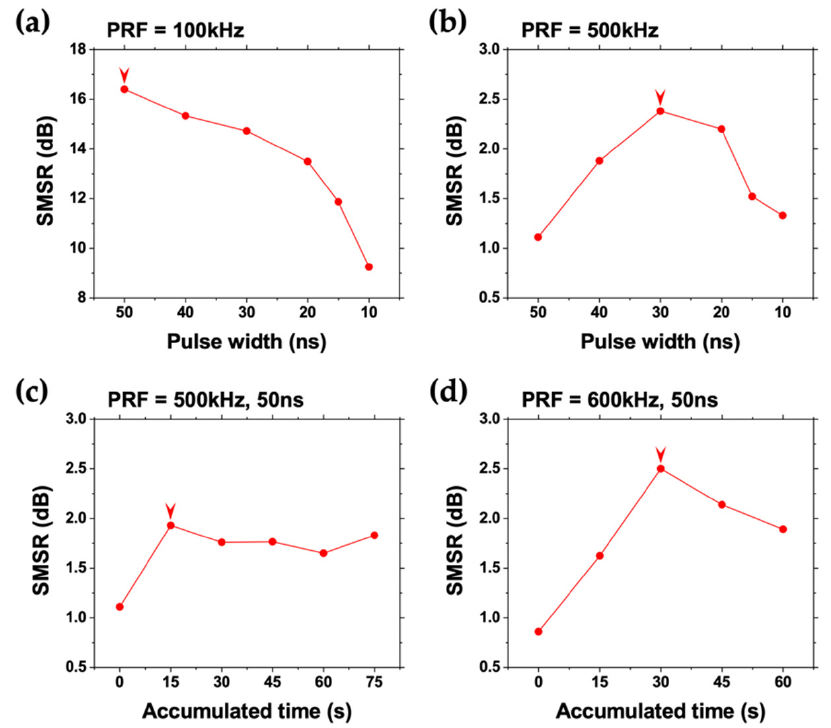
Figure 8. Relevant side mode suppression ratios of the employed PCSEL operated under different conditions. The highest SMSRs are labeled with red arrows. ( a ) SMSRs extracted from Figure 5a. While the pulse width is shrunk from 50 ns to 10 ns, the corresponding SMSRs drop from 16.4 dB to 9.25 dB, respectively. ( b ) SMSRs extracted from Figure 5b. Two modes emerge at the same time under this condition, and thus the corresponding SMSRs are much lower compared to the case of ( a ). The highest SMSR is 2.38 dB with the pulse repetition frequency and pulse width of 500 kHz and 30 ns, respectively. ( c ) SMSRs extracted from Figure 7a. Two modes emerge at the same time under this condition, and the highest SMSR of 1.93 dB appears at the accumulated time of 15 s. ( d ) SMSRs extracted from Figure 7b. Two modes emerge at the same time under this condition, and the highest SMSR of 2.14 dB appears at the accumulated time of 30 s.